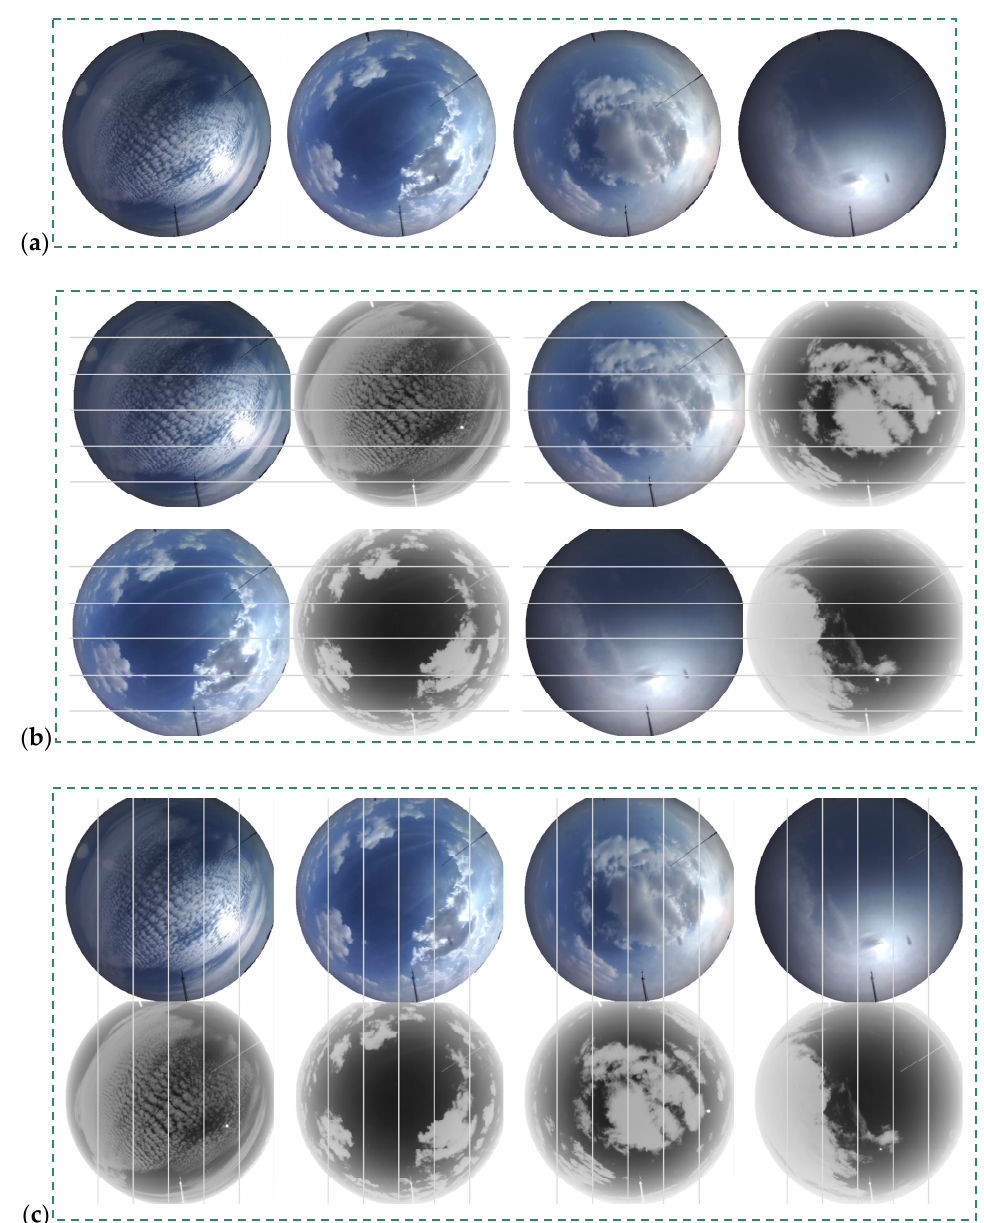
Figure 8. Registration results of the four visible and infrared all-sky image pairs. ( a ) Original visible all-sky images. These original images are warped and registered with infrared images. ( b ) and ( c ) present the horizontal and vertical comparison between the infrared images and the warped visible images, respectively. The gray lines are plotted to better compare the results.